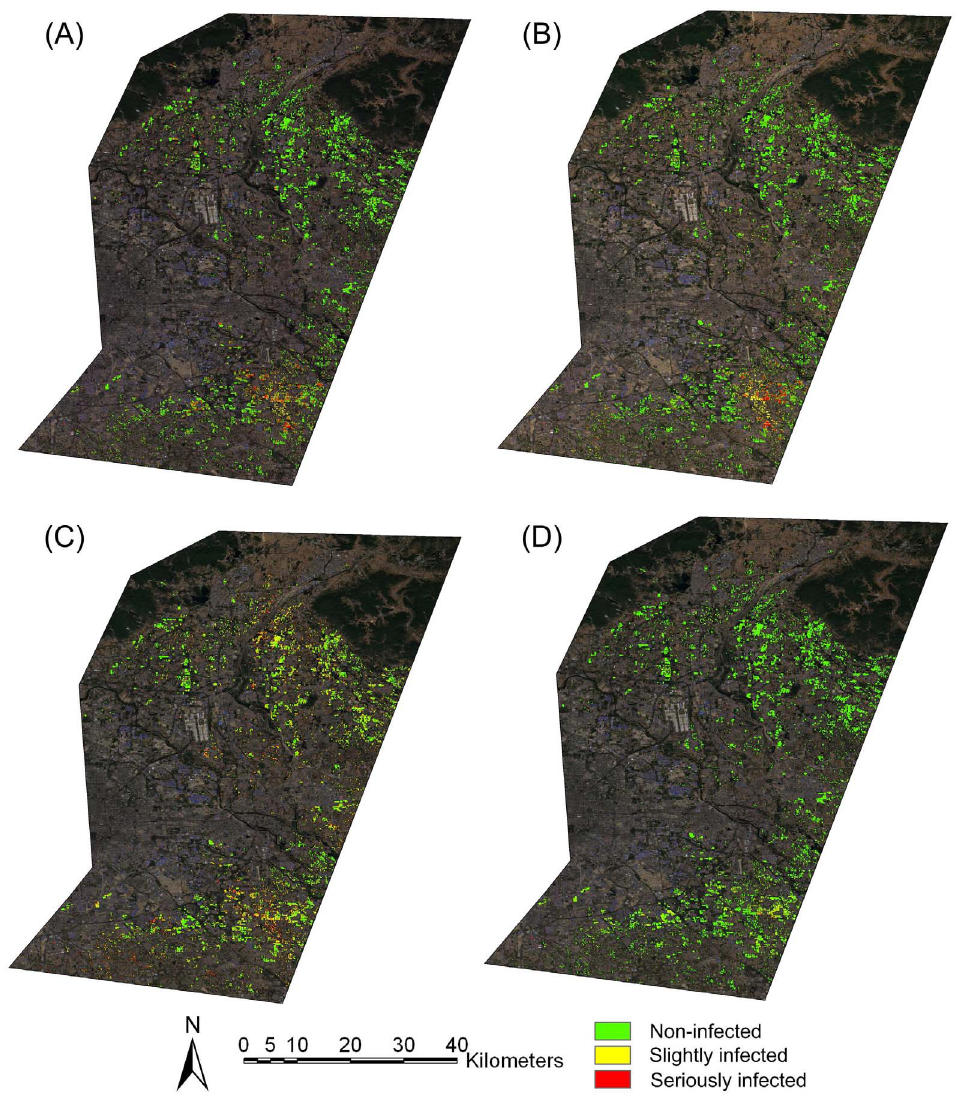
Figure 7. Infection map of powdery mildew produced by MD (A), MLC (B), PLSR (C) and MTMF (D).